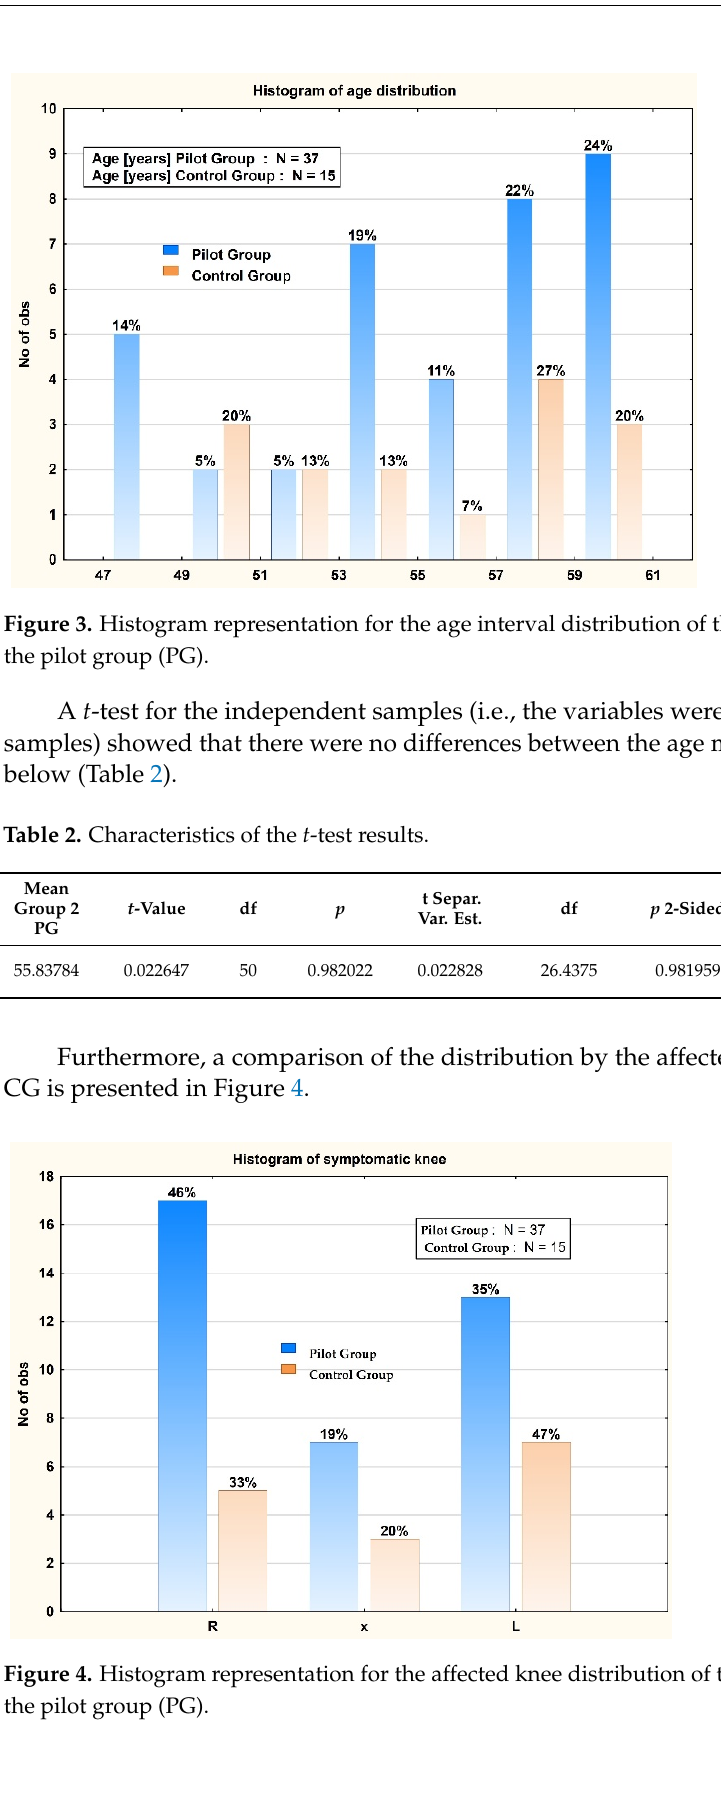
Figure 2. Histogram representation for the gender distribution of the control group (CG) and the pilot group (PG).